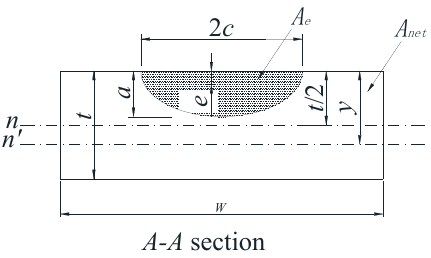
Figure 7. Neutral axis shift due to crack growth.